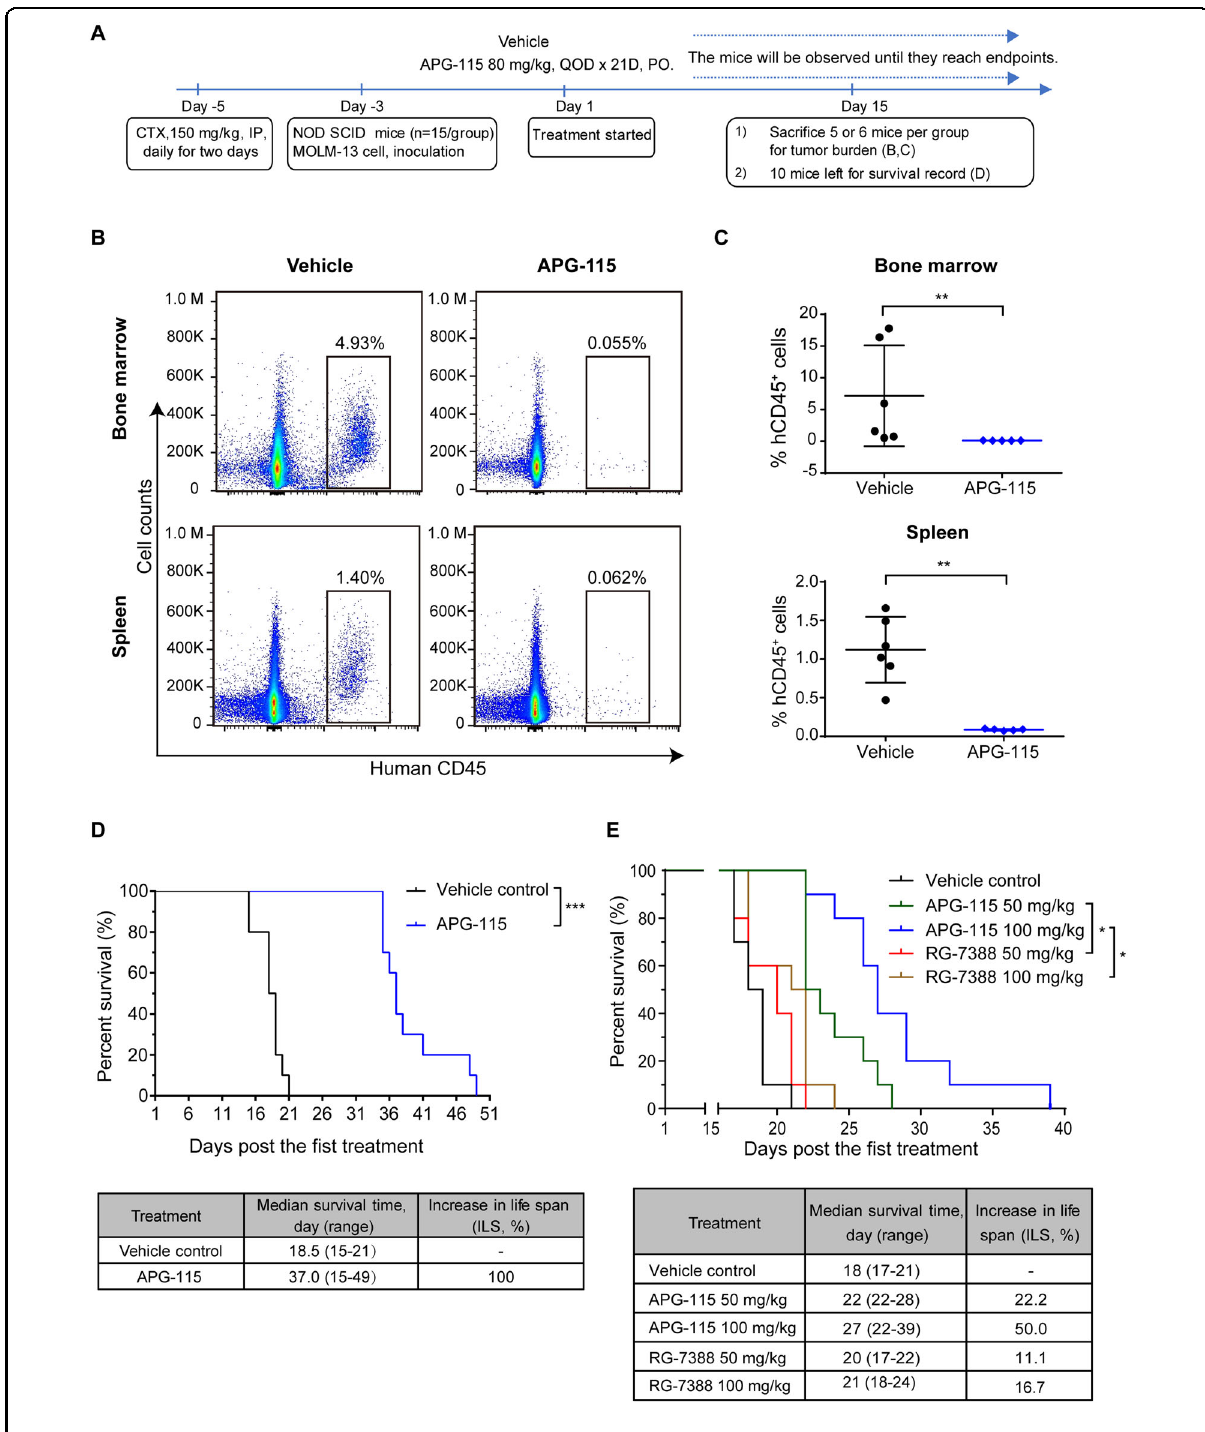
Fig. 2 (See legend on next